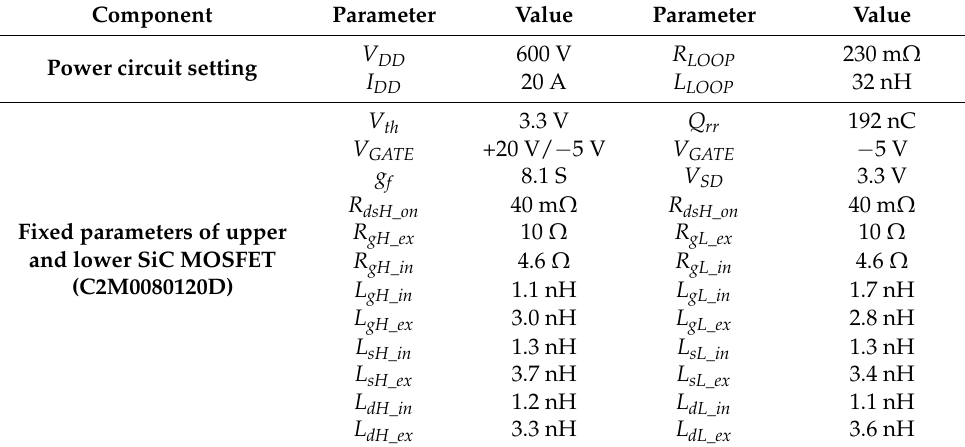
Figure 17. Photograph of the double pulse test platform. Table 2. Fixed Parameters Setup.